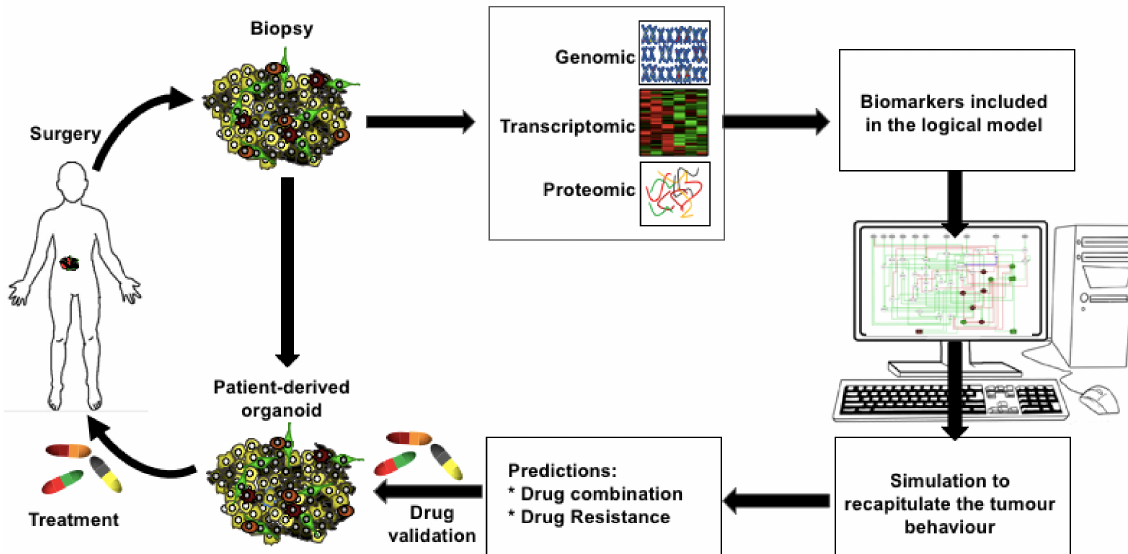
Figure 6. Scheme to establish personalised chemotherapeutic drug regiments using logical modelling. A tumour biopsy is processed to gather genomic, transcriptomic, and proteomic datasets and to establish cultured organoids. A logical model, including the biomarkers identified in the tumour datasets, is trained to recapitulate the tumour state. Starting from this state, systematic model perturbations allow predictions of drug combinations, which can revert the tumour state to a non-tumour state and overcome possible drug resistance mechanisms. Predicted drug combinations are validated in patient-derived organoid before safe clinical